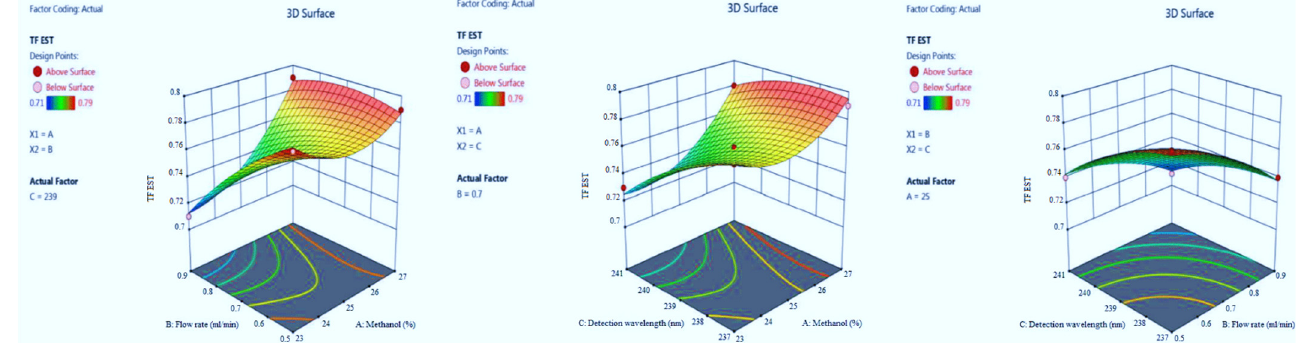
Figure 5. 3D responses for EST tailing factor in terms of AB, AC, and BC.